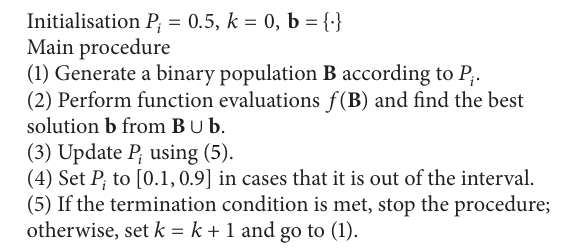
Algorithm 1: Population-based incremental